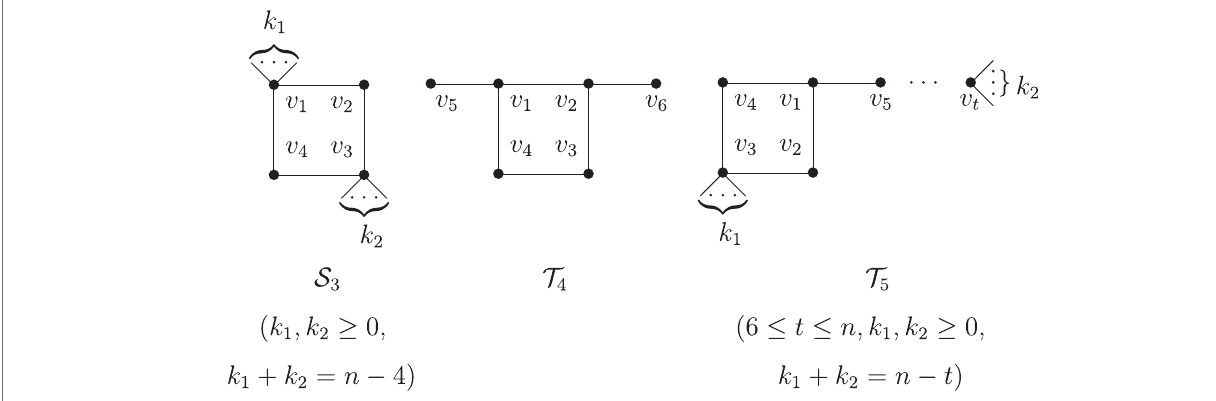
FIGURE 3 | Graphs S 2 , T 4 , and T 5 .